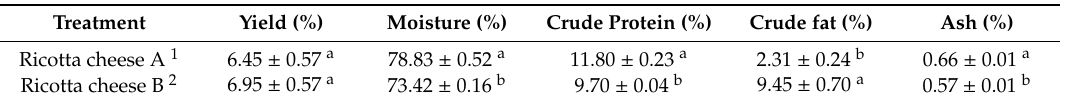
Table 4. Composition of ricotta cheeses made from goat milk and cheese whey (replicated for three di ff erent